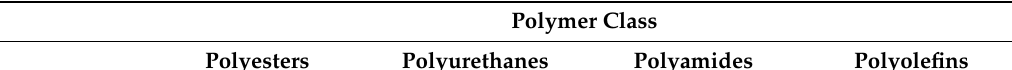
Table 1. Main polymer classes obtained from FLW. Adapted with permission from Ref. [58], Jul.02, 2022, MDPI AG.